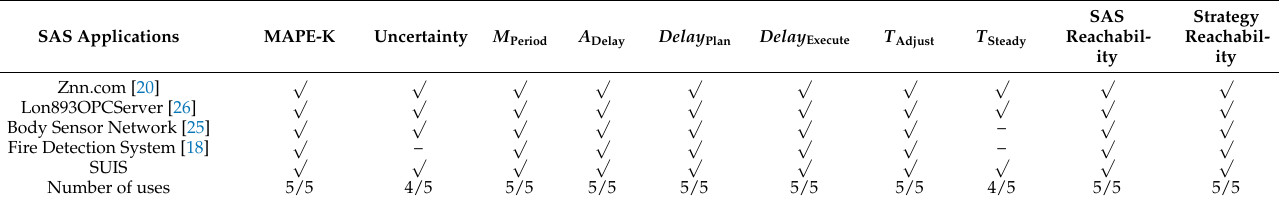
Table 5. The template reusability for each example application.